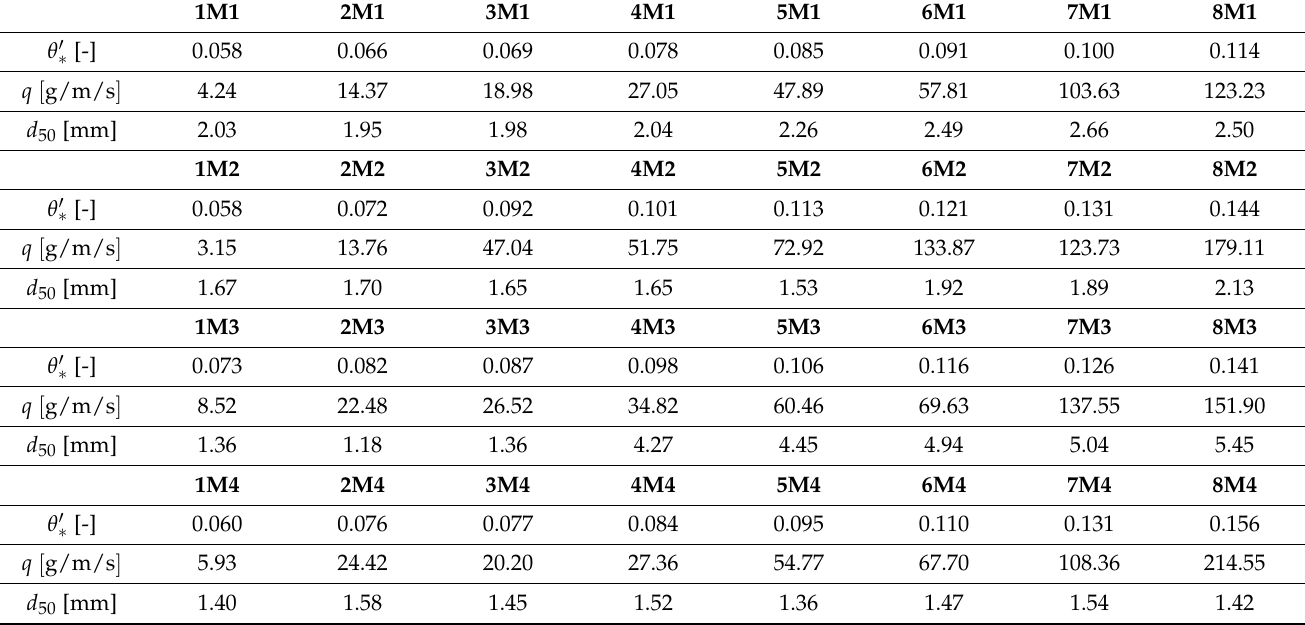
Table 2. Main parameters and transport results by Elhakeem and Imran (2012)